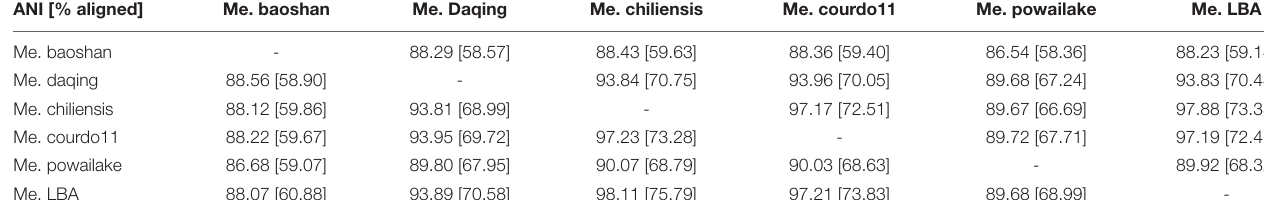
TABLE 3 | Whole genome average nucleotide identities (ANI) between megaviruses. ANI [% aligned]